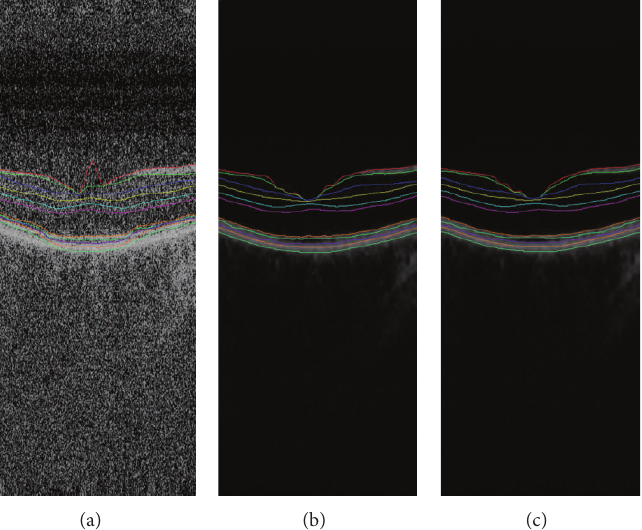
Figure 14: A comparison between the segmented layers of a 650×512×128 Topcon 3D OCT-1000 imaging system using proposed method in [53]. From left to right: original image, denoised image by nonlocal homomorphic BiGaussRayMixShrinkL method , and local homomorphic BiGaussRayMixShrinkL method